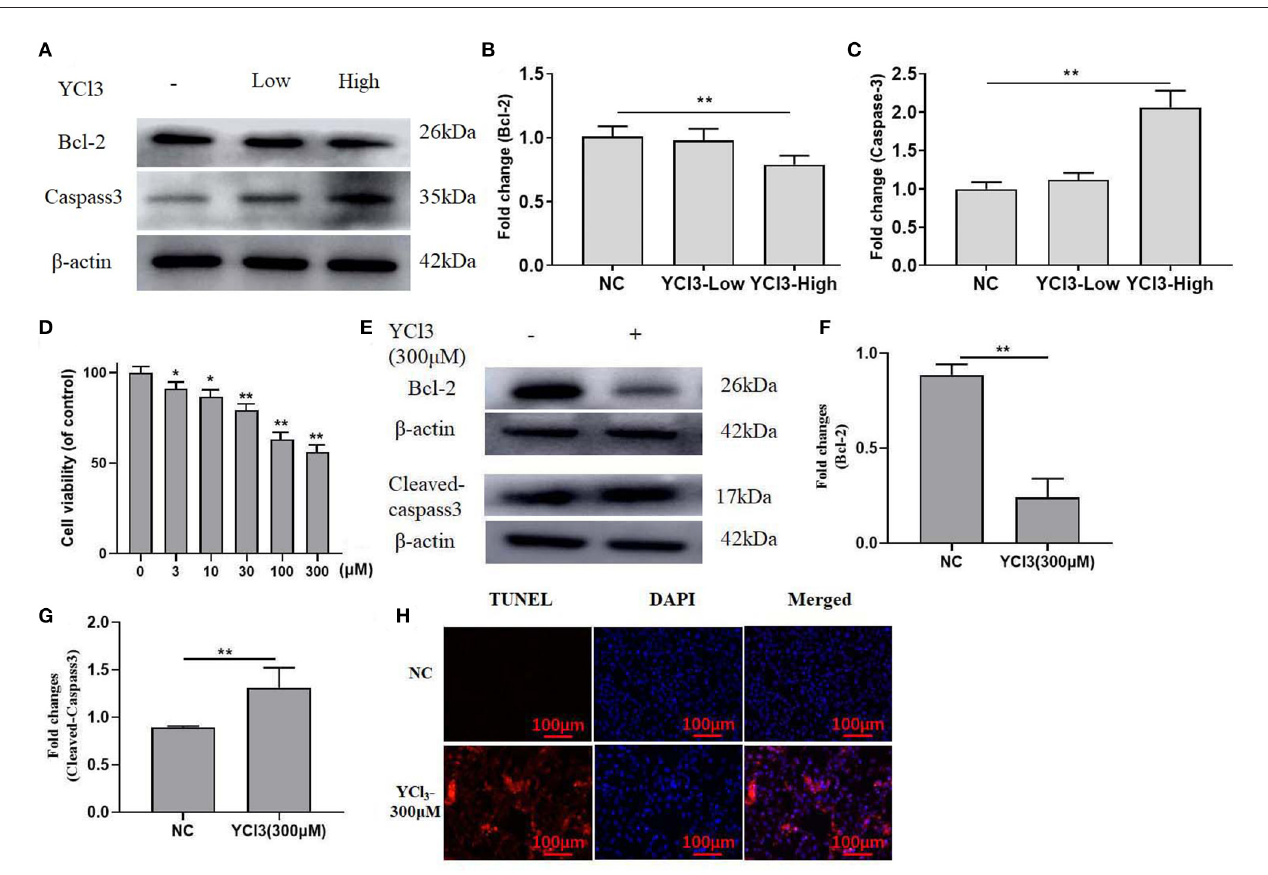
FIGURE2 The effects of YCl 3 on cell apoptosis. The protein expression of Bcl-2 (A, B) and caspase-3 (A, C) in the testis was detected by Western blot. (D) CCK8 assays were detected for the effects of YCl 3 on the cell viability, the statistical difference was compared to the NC group (0 µ M). Western blot assays were conducted for determination of Bcl-2 (E, F) , and cleaved-caspase-3 (E, G) protein expression. TUNEL/DAPI assays were conducted for apoptosis detection (H) . * P < 0.05, ** P < 0.01. NC, negative control; YCl 3 -Low, 12 mmol/L YCl 3 ; YCl 3 -High, 24 mmol/L YCl 3